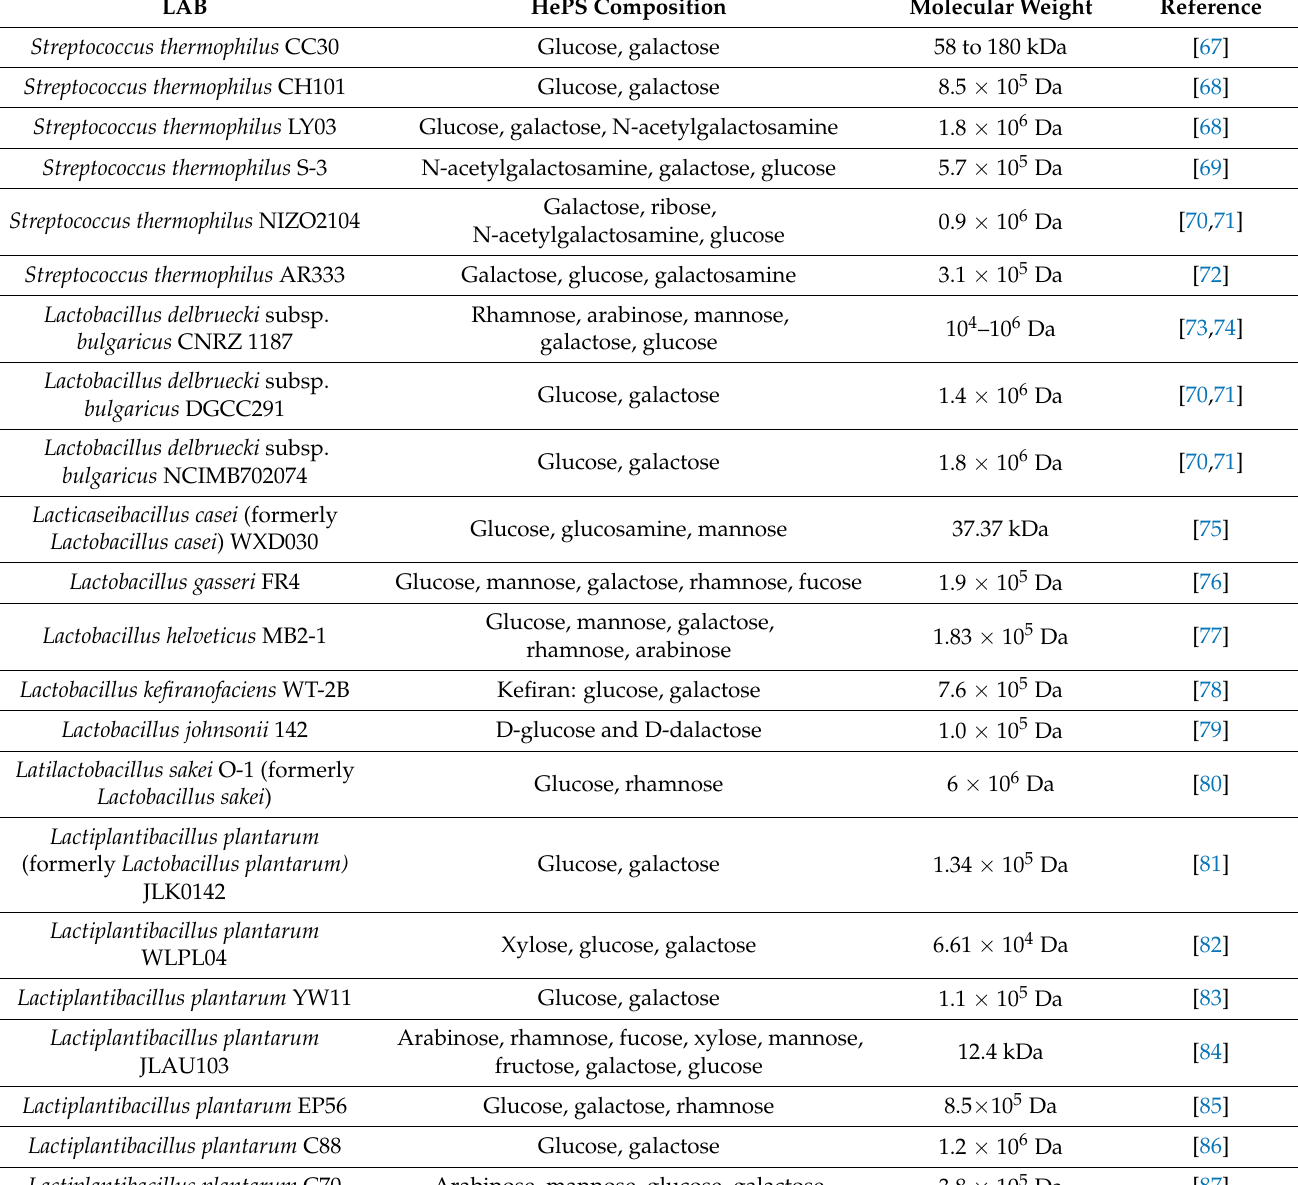
Table 2. Heteropolysaccharides produced by lactic acid